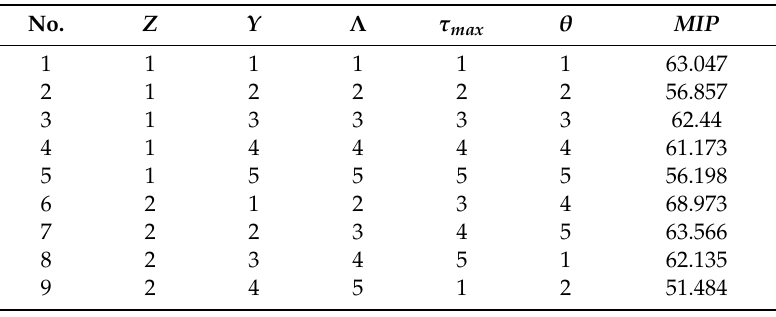
Table A2. HDDE algorithm parameters orthogonal experiment